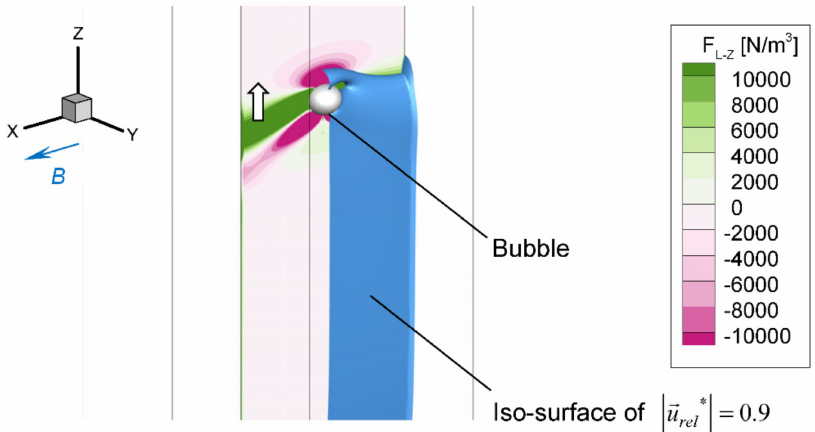
Figure 26. Wake induced by the Lorentz force for B 0 = 1.12 T showing the iso-surface of the magnitude of the relative velocity | u rel ∗ | = 0.9, drawn only in the half domain for the sake of clarity. An upward- directed force is identified by the color green. The Lorentz force, acting upward (the green region), induces the wake, which is broadened in the x